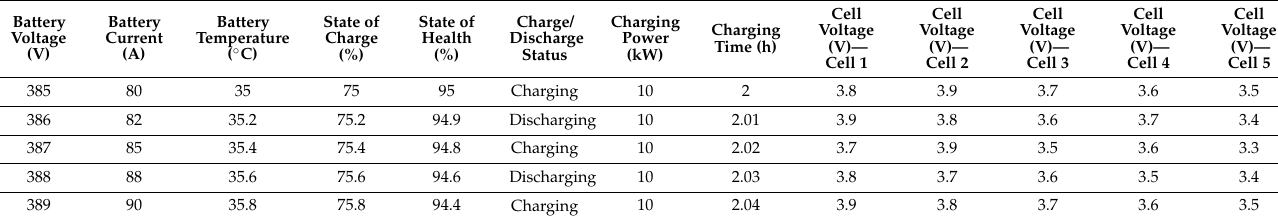
Figure 2. Overview of Research Process. Table 2. Sample sensor